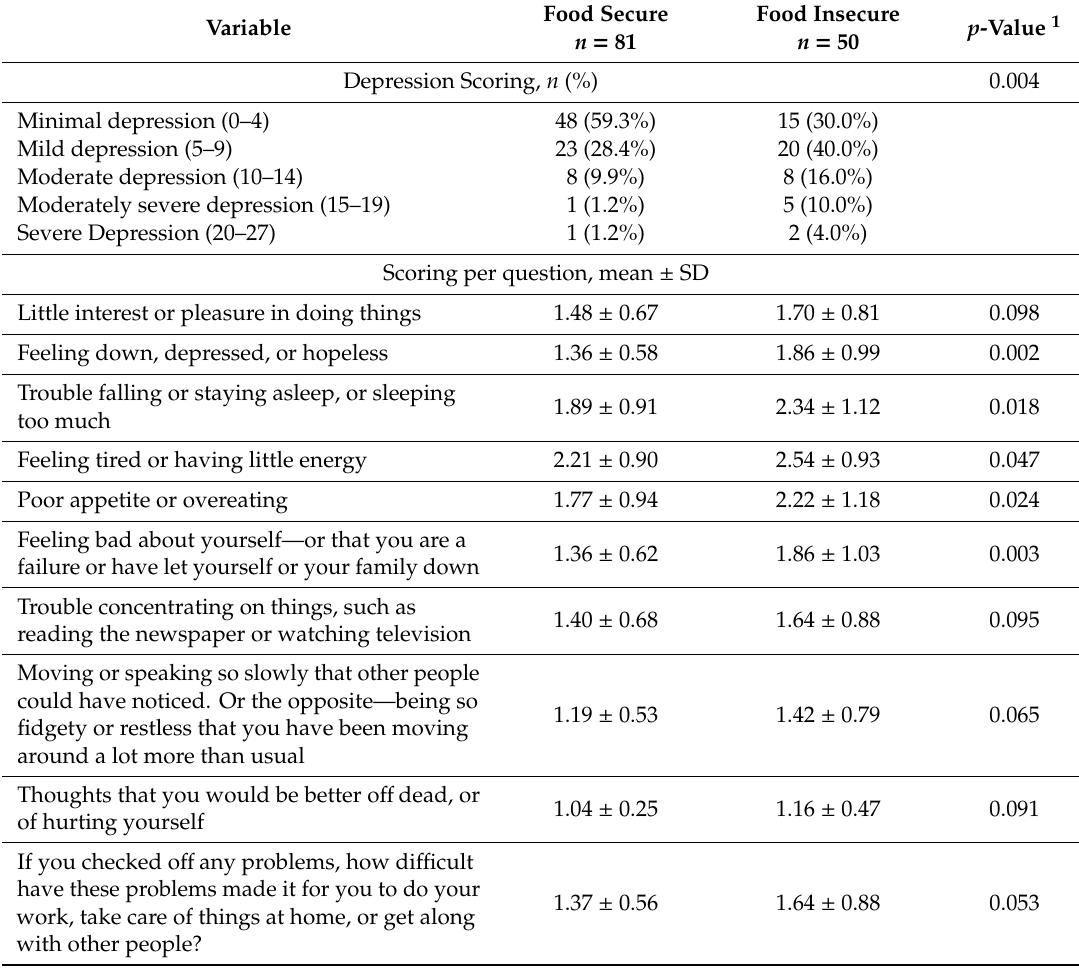
Table 2. Patient Health Questionnaire-9